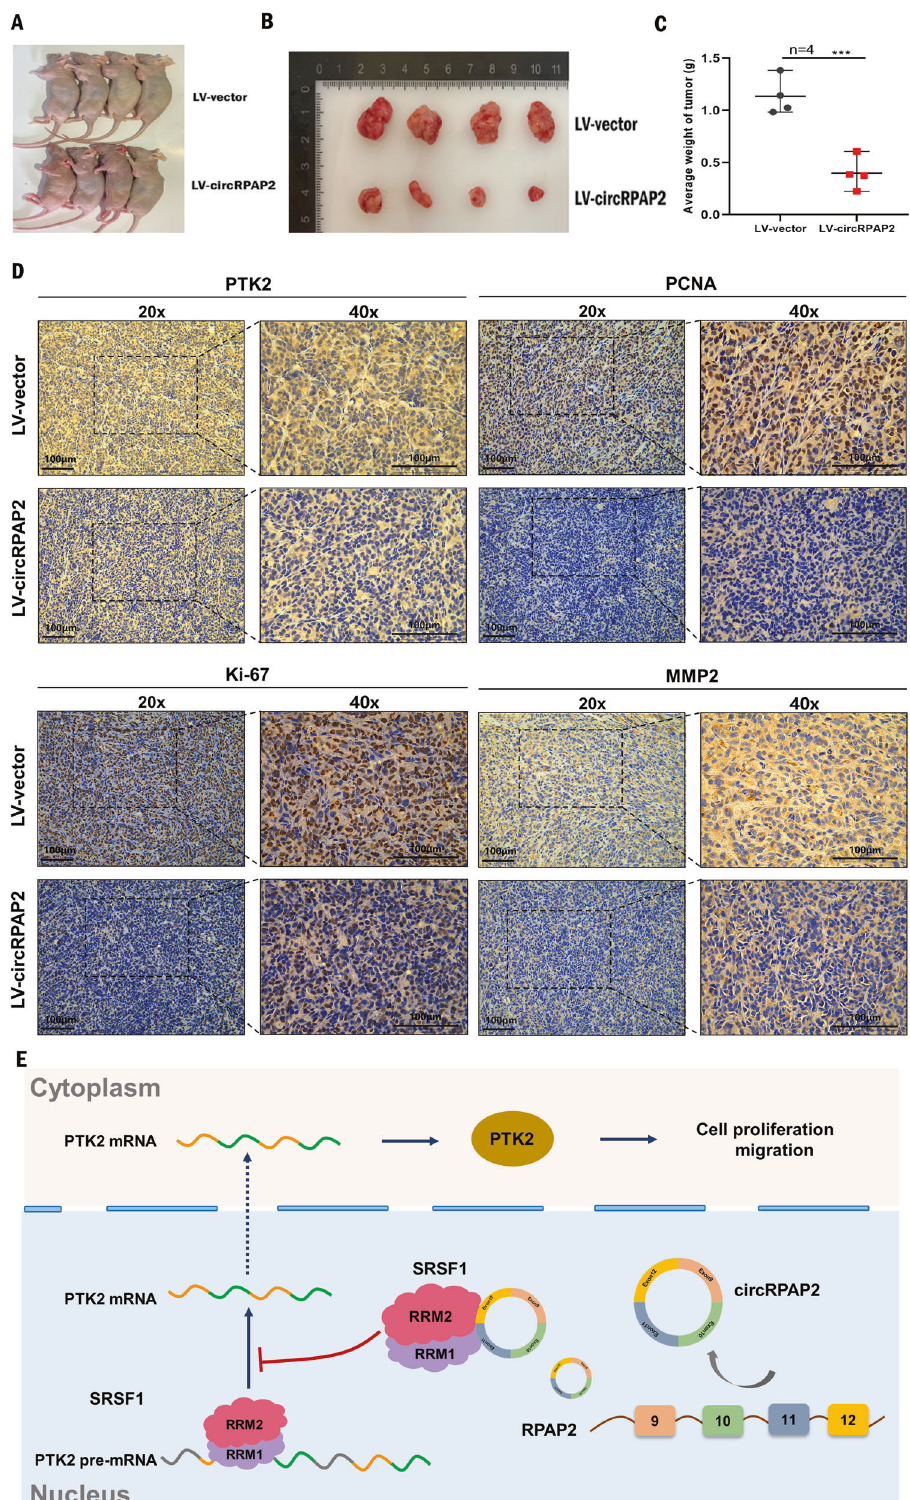
Fig. 7 CircRPAP2 inhibits BC growth in vivo. A Representative images of female nude mice injected with MDA-MB-231 cells (4 mice per group). B Representative images of xenograft tumors in nude mice. C Average tumor weight of nude mice. D IHC staining of PTK2, PCNA, Ki- 67, and MMP2 in xenograft tumors. (* P < 0.05, ** P < 0.01, *** P < 0.001, **** P <